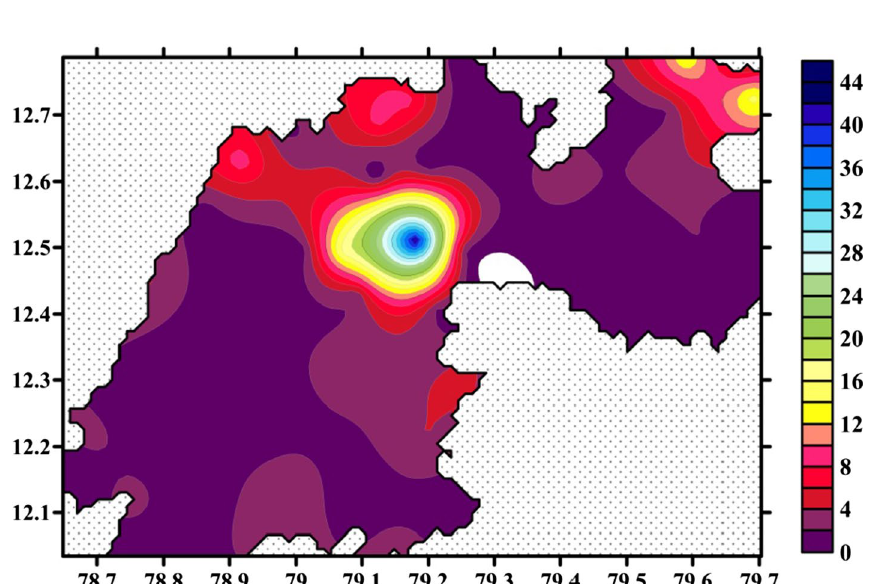
Fig. 12 Spatial distribution of uranium concentration in the study